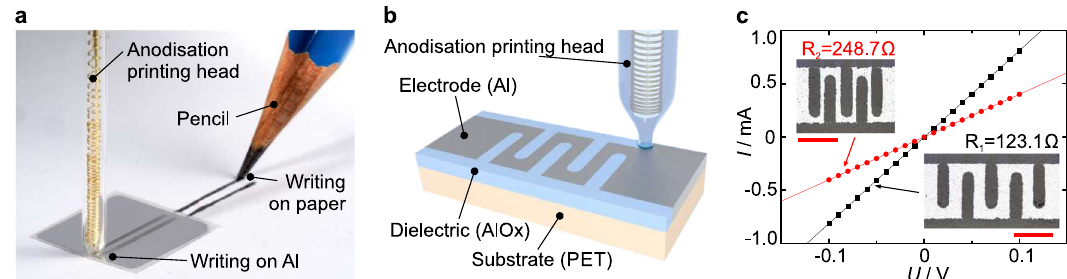
Fig. 1 Direct writing of fl exible thin- fi lm resistors. a Photograph of the Scanning Droplet Cell Microscope (SDCM) as printing head applied in direct writing of oxides on valve-metal coated substrates. The method is comparable to other writing-like printing processes such as drawing with a pencil. b Schematic of resistor meanders fabricated with the anodic printing head. c Current – voltage characteristics of two meander structures and their corresponding resistance values together with optical microscopy images of the structures. Larger meanders yield lower resistance values. Scale bars: 500